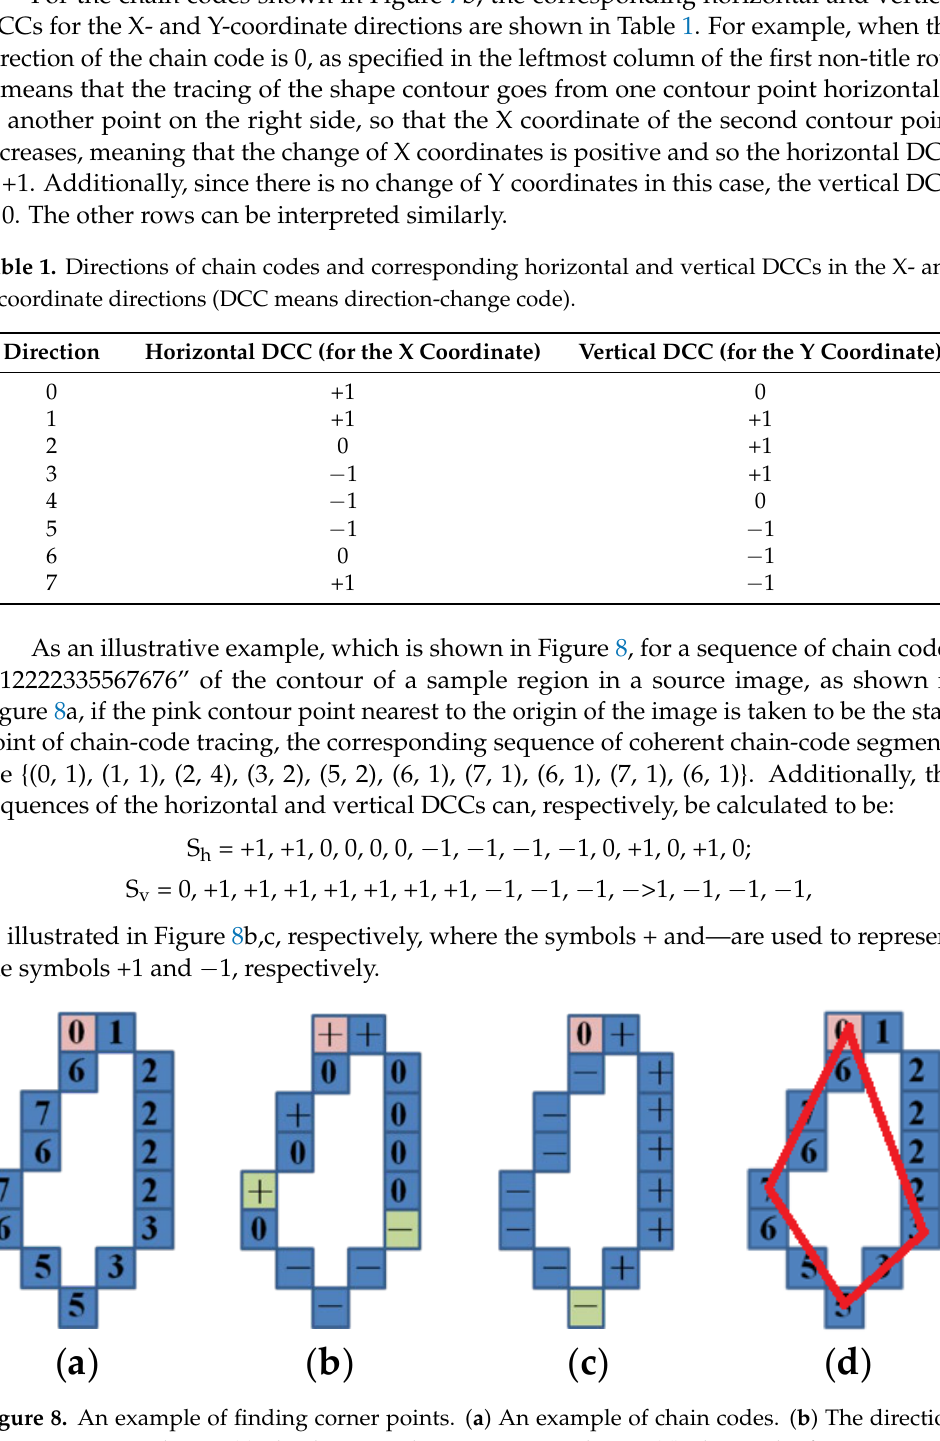
Table 1. Directions of chain codes and corresponding horizontal and vertical DCCs in the X- and Y-coordinate directions (DCC means direction-change code). Direction Horizontal DCC (for the X Coordinate) Vertical DCC (for the Y Coordinate)